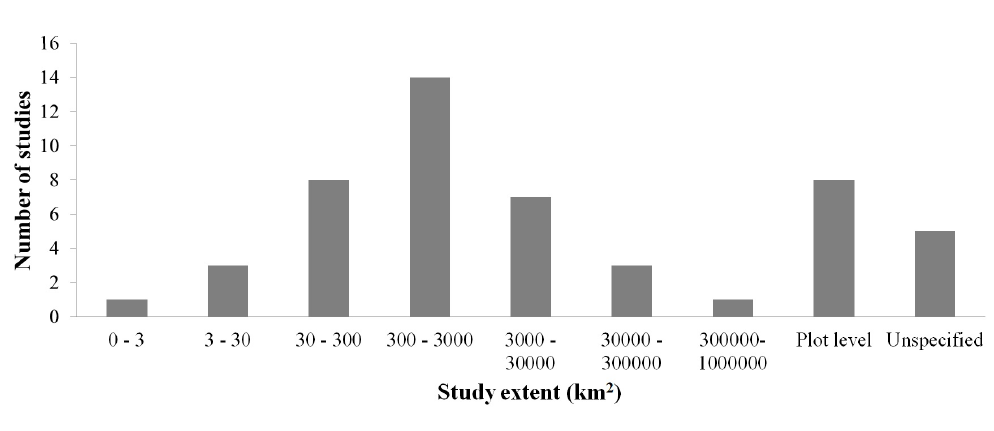
Figure 4. Spatial extent of study sites in land use-related studies selected for analysis. Total area is reported for studies that covered more than one site. Plot level refers to studies that conducted assessments on individual field